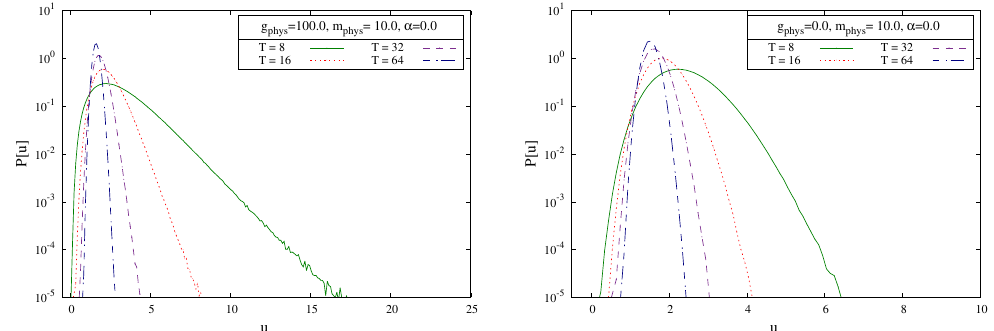
Figure 13 . The decay of the drift terms. (Left) Supersymmetric anharmonic oscillator with the parameters m phys = 10 . 0 and g phys = 100 . 0 . (Right) Supersymmetric harmonic oscillator with parameters m phys = 10 . 0 and g phys = 0 . 0 .